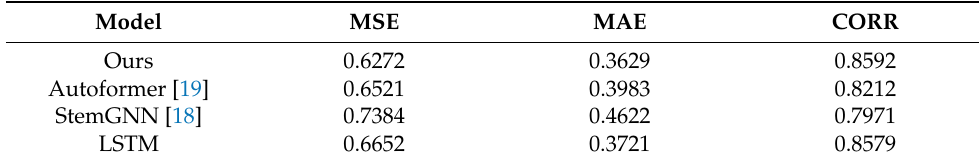
Table 2. Comparison of Results Different